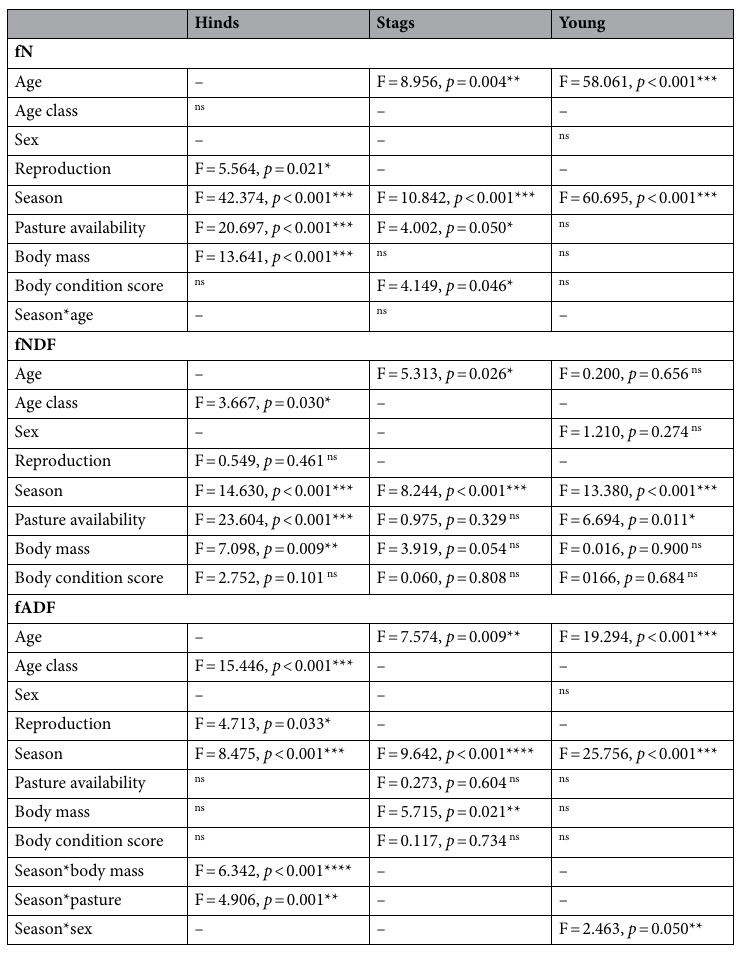
Table 3. General linear mixed models explaining the content of faecal nutrients in red deer hinds, stags and young (nitrogen—fN; neutral detergent fibre—fNDF; acid detergent fibre—fADF; see Table 2 for more details about the selection process). Dashes indicate variables not included in a certain model. ns Indicate variables included in a certain model, but not significant. Statistically significant differences at 0.05, 0.01, and 0.001 are indicated by *, ** and ***,